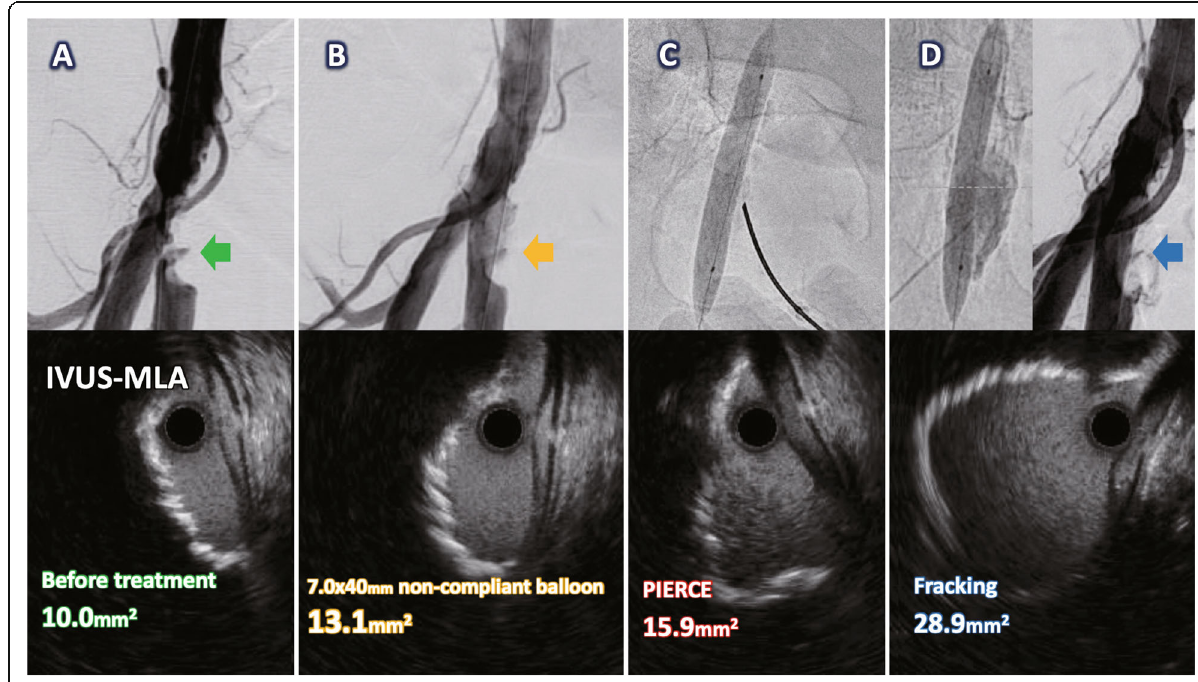
Fig. 2 Angiography and intravascular ultrasound (IVUS) of the treatment with the fracking technique in case 2. A Control angiography for quantitative vessel analysis (QVA) showed eccentric calcified plaque in the distal common femoral artery with stenosis of 96% (green arrow), and IVUS before treatment showed a minimal lumen area (MLA) of 10.0-mm 2 . B After balloon dilatation with a 7.0 × 40-mm noncompliant balloon, QVA showed 42% stenosis (yellow arrow), and the MLA was 13.1-mm 2 . C After the 7.0 × 40-mm noncompliant balloon inflation and percutaneous direct needle puncture of calcified plaque (PIERCE) (Ichihashi et al. 2014), the MLA was unsatisfactory, at 15.9-mm 2 . D After the fracking technique was repeated at two locations at up to 5-atm, QVA showed an improvement in stenosis to 26% (blue arrow), and the MLA was significantly greater, at 28.9-mm